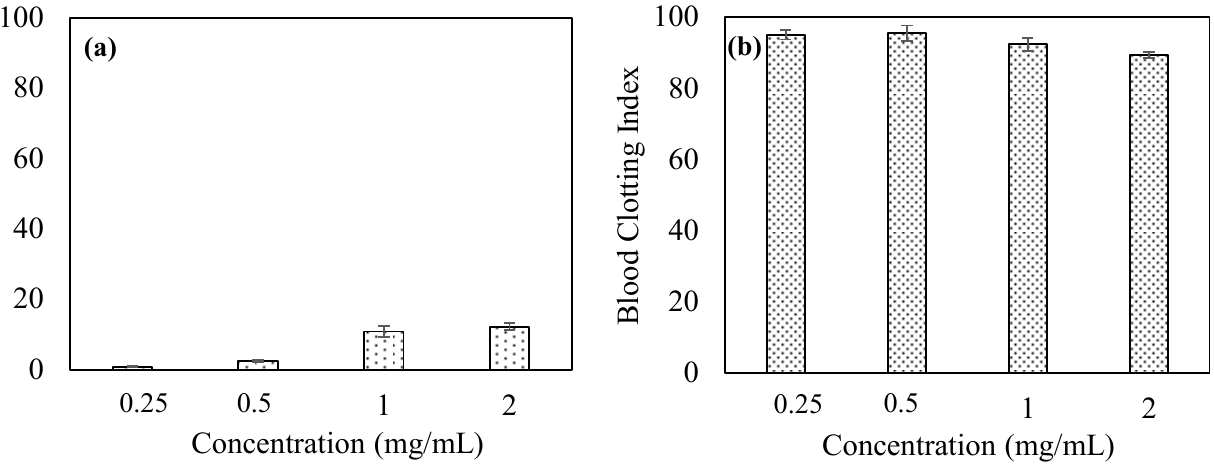
Figure 5. ( a ) Hemolysis and ( b ) blood clotting index at various concentration of p (TA)/200X particles.